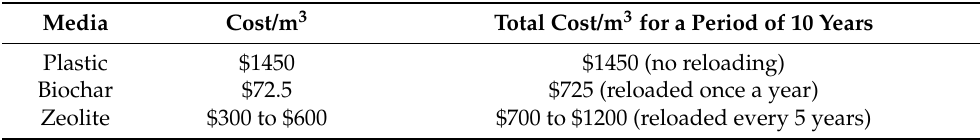
Table 5. Cost analysis of the three types of biofilter